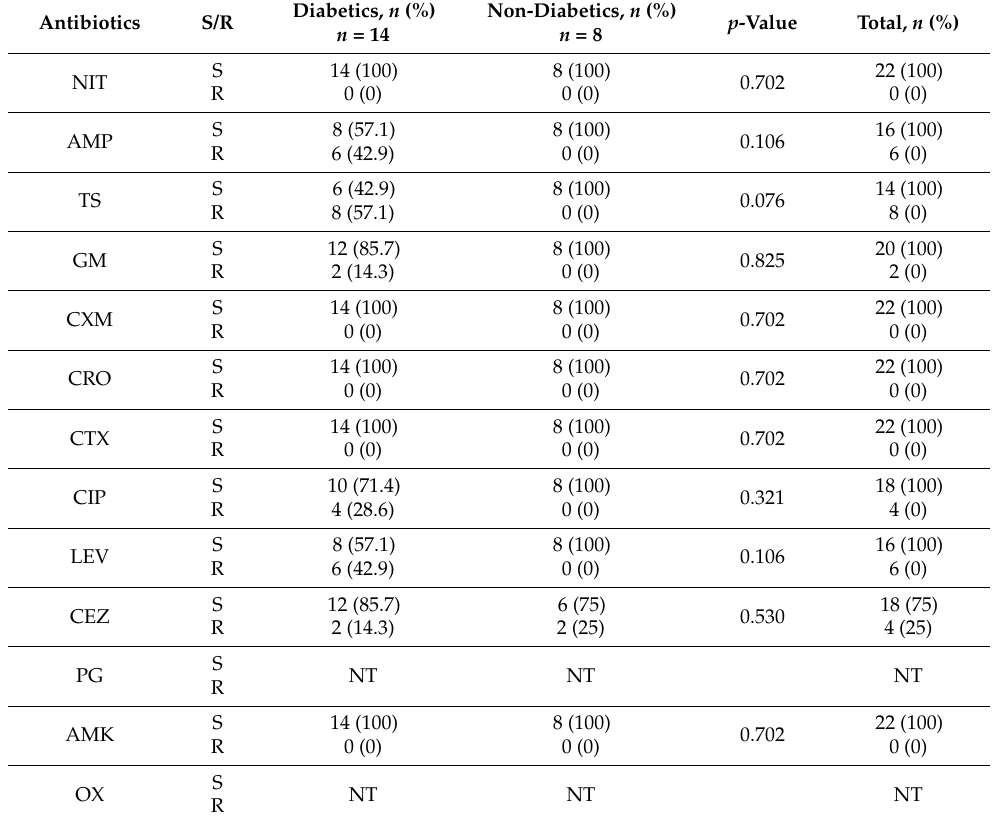
Table 5. Susceptibility pattern of E. coli isolates from diabetic and non-diabetic individuals with UTI to different